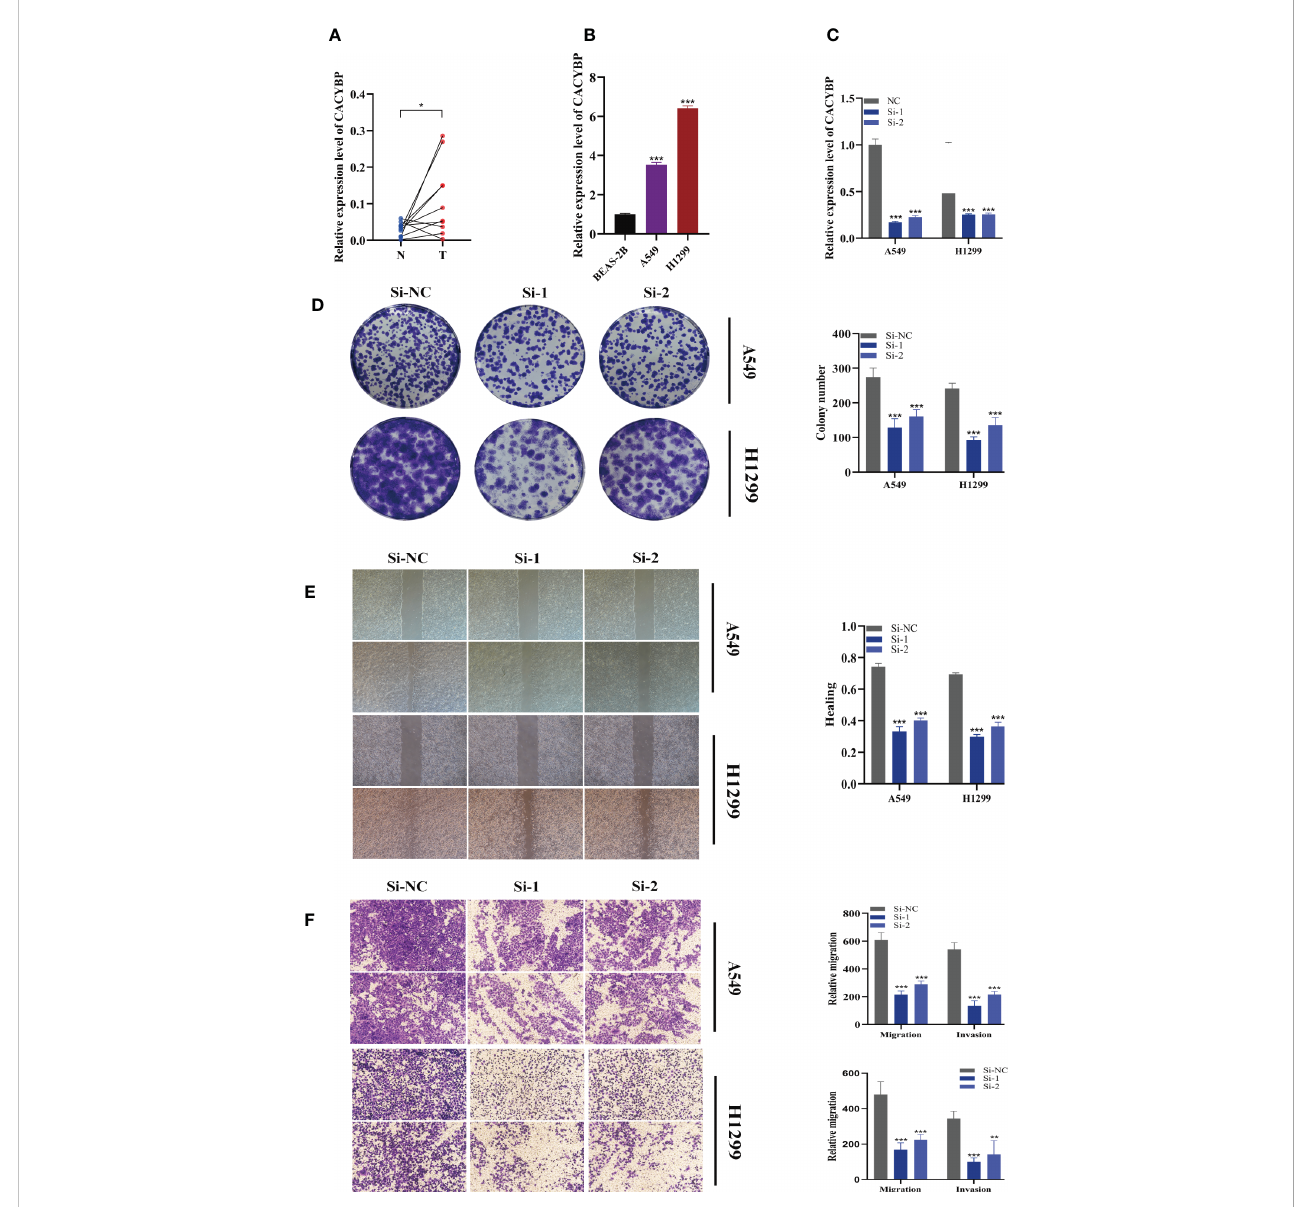
FIGURE 10 The role of CACYBP in LUAD. (A) Relative expression of CACYBP in tumor and paracancerous tissues in LUAD and CACYBP was highly expressed in tumor tissues compared with adjacent tissues (B) CACYBP was highly expressed in LUAD cell lines compared to healthy human lung epithelial BEAS-2B cell line. (C) RT-qPCR was performed to measure the relative expression of CACYBP in LUAD cells transfected with si-RNAs or negative control (NC). (D) Colony formation assay displayed that cell with reduced CACYBP expression exhibited a signi fi cant reduction in the numbers of colonies, compared with the NC group. (E) Scratch-wound healing assay. A signi fi cant reduction in migration rate was observed in cells with reduced CACYBP gene expression. (F) Transwell assay showed that downregulation of CACYBP expression inhibited the migration and invasion capacity of LUAD cells. To demonstrate the accuracy and reproducibility of the results, three independent experiments were performed in two LUAD (A549, H1299) cell lines and all data were presented as the means ± SD of three independent experiments. * P < 0.05, ** P < 0.01, *** P <